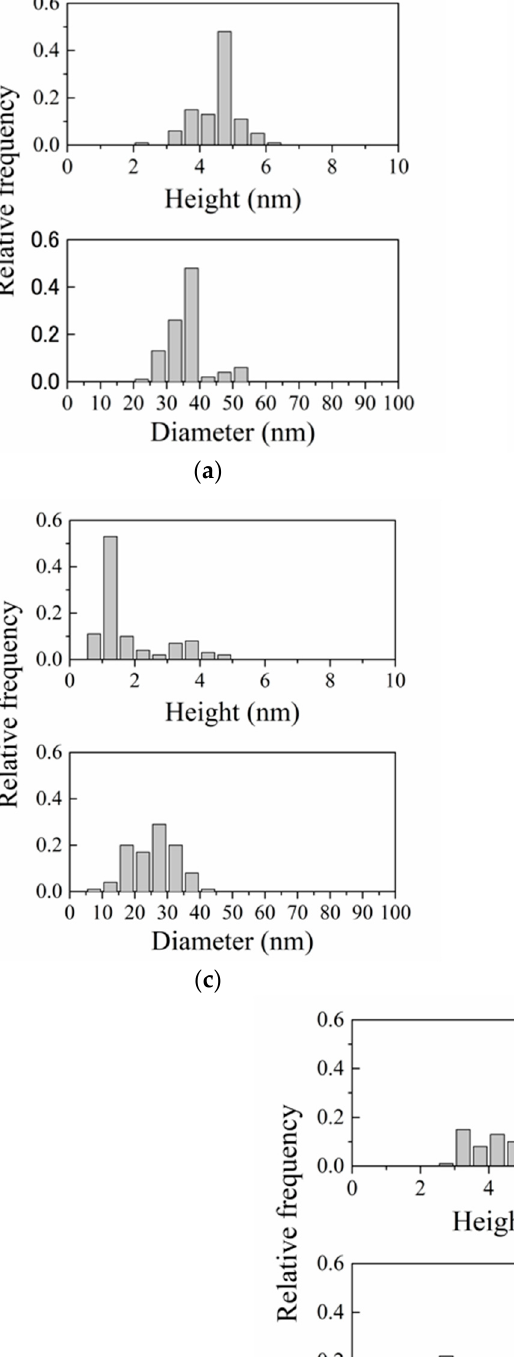
Figure 2. Atomic force microscopy (AFM) images for samples irradiated with As for ( a ) 240 s at 470